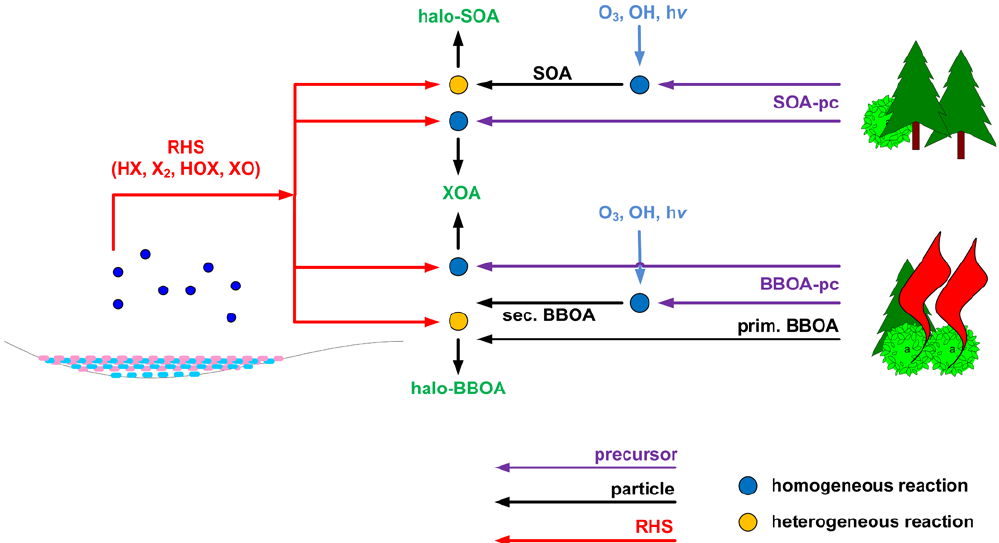
Fig. 1. Possible interactions of RHS released from sea-salt aerosol or salt lakes with SOA, BBOA and related gaseous precursors (SOA- pc, BBOA-pc), forming halogenated SOA/BBOA (halo-SOA/halo-BBOA) via heterogeneous reaction or halogen-induced organic aerosol (XOA) via homogeneous